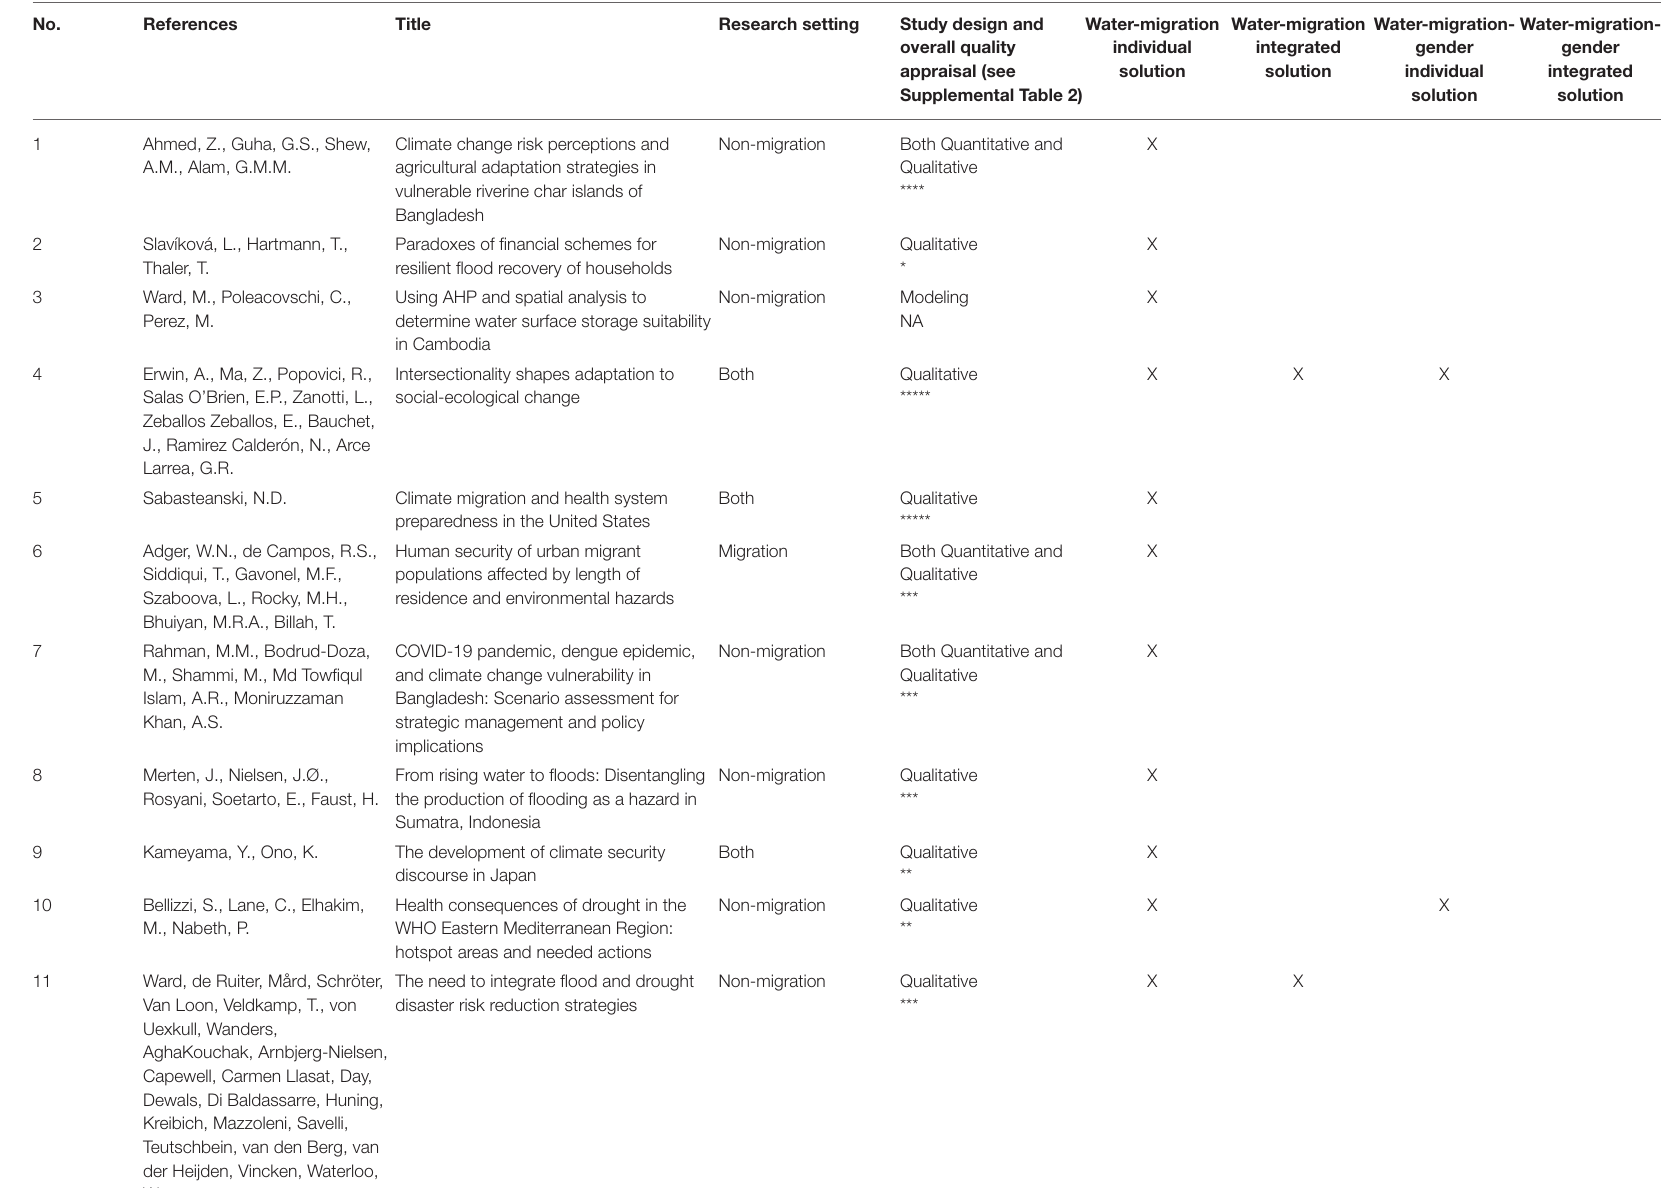
TABLE 3 | Included